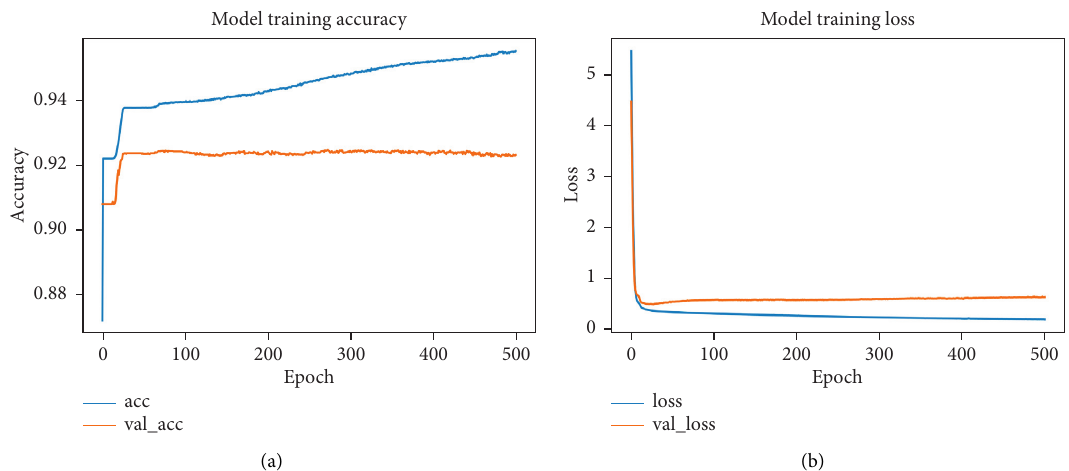
Figure 23: Training statistics on the log of the HF acid production unit.